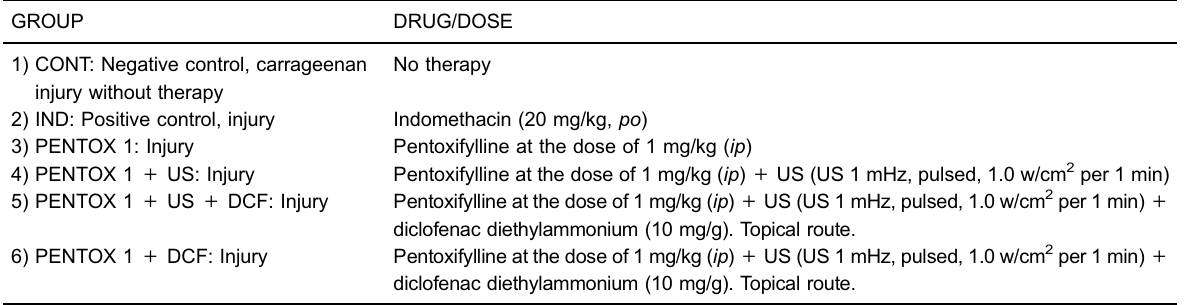
Table 2. Protocol 2 for evaluation of the anti-in fl ammatory and antinociceptive effect of phonophoresis associated with pentoxifylline in paw edema tests.